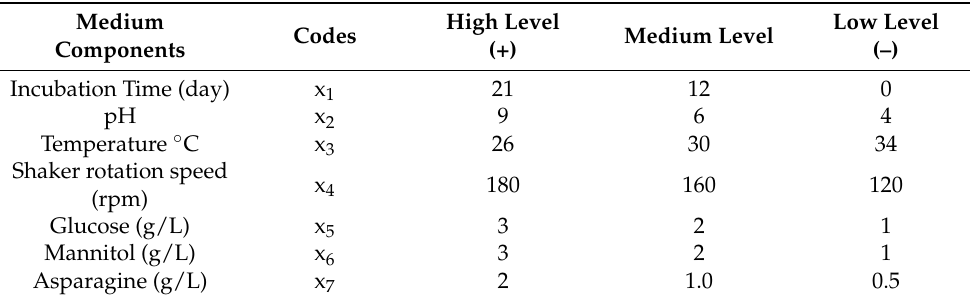
Table 6. The min and max range for each independent factor used for pharmaceutically active compounds production from Streptomyces SUK